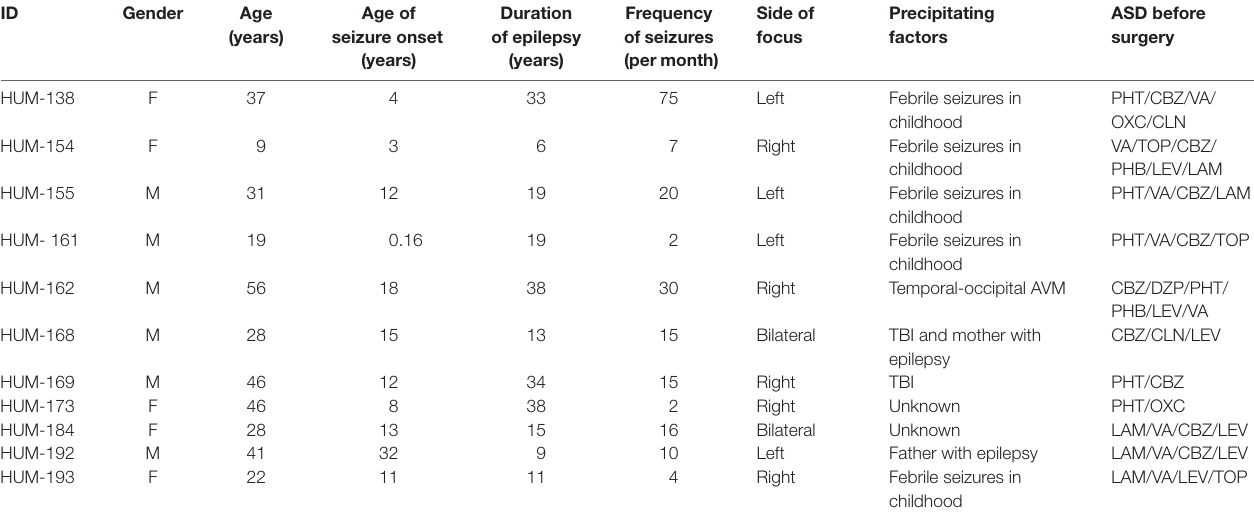
TABLE 1 | Clinical data of patients with drug-resistant mesial temporal lobe epilepsy (DR-MTLE). ID Age